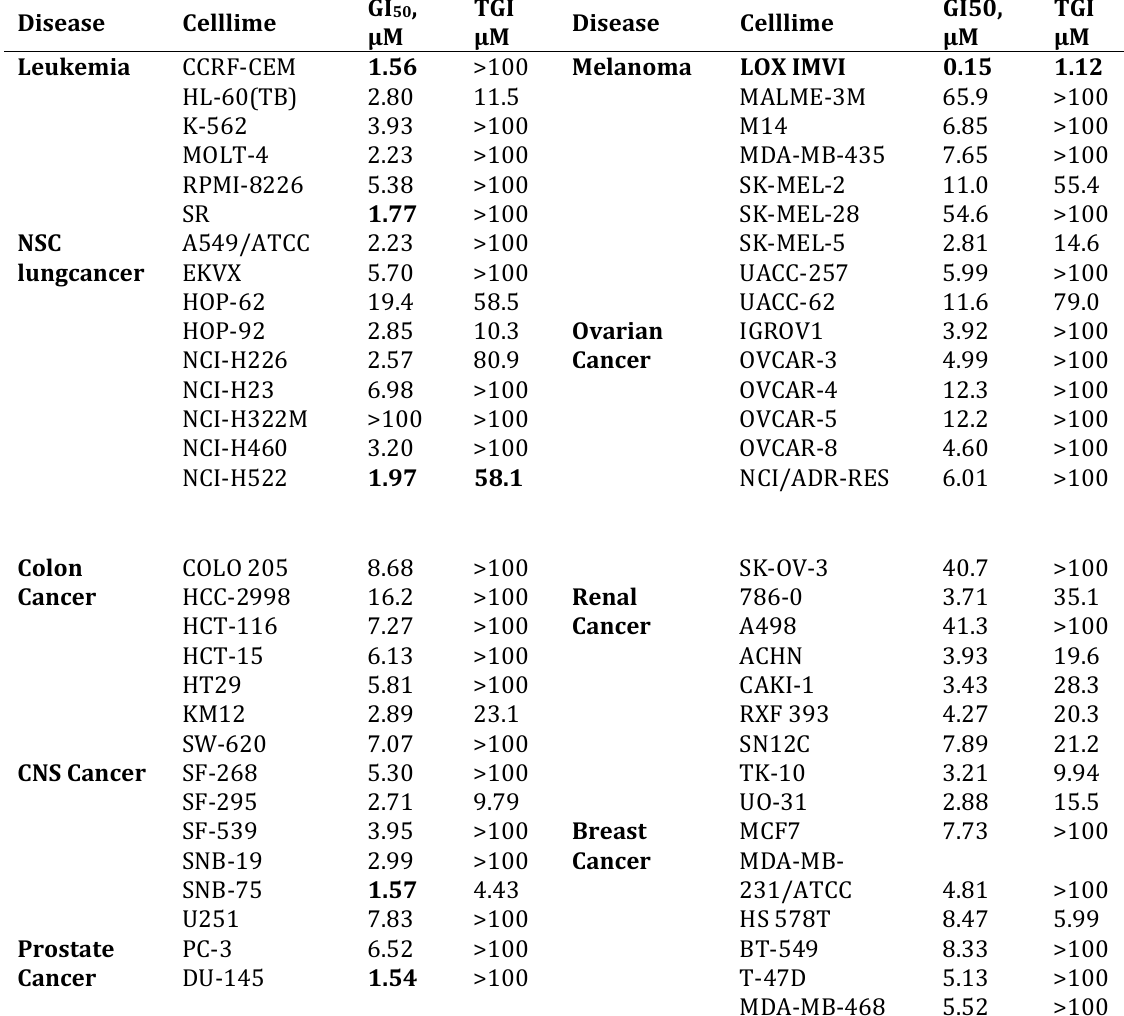
Table 2. In vitro anticancer activity at 60 human tumor cell lines for compound 3c.